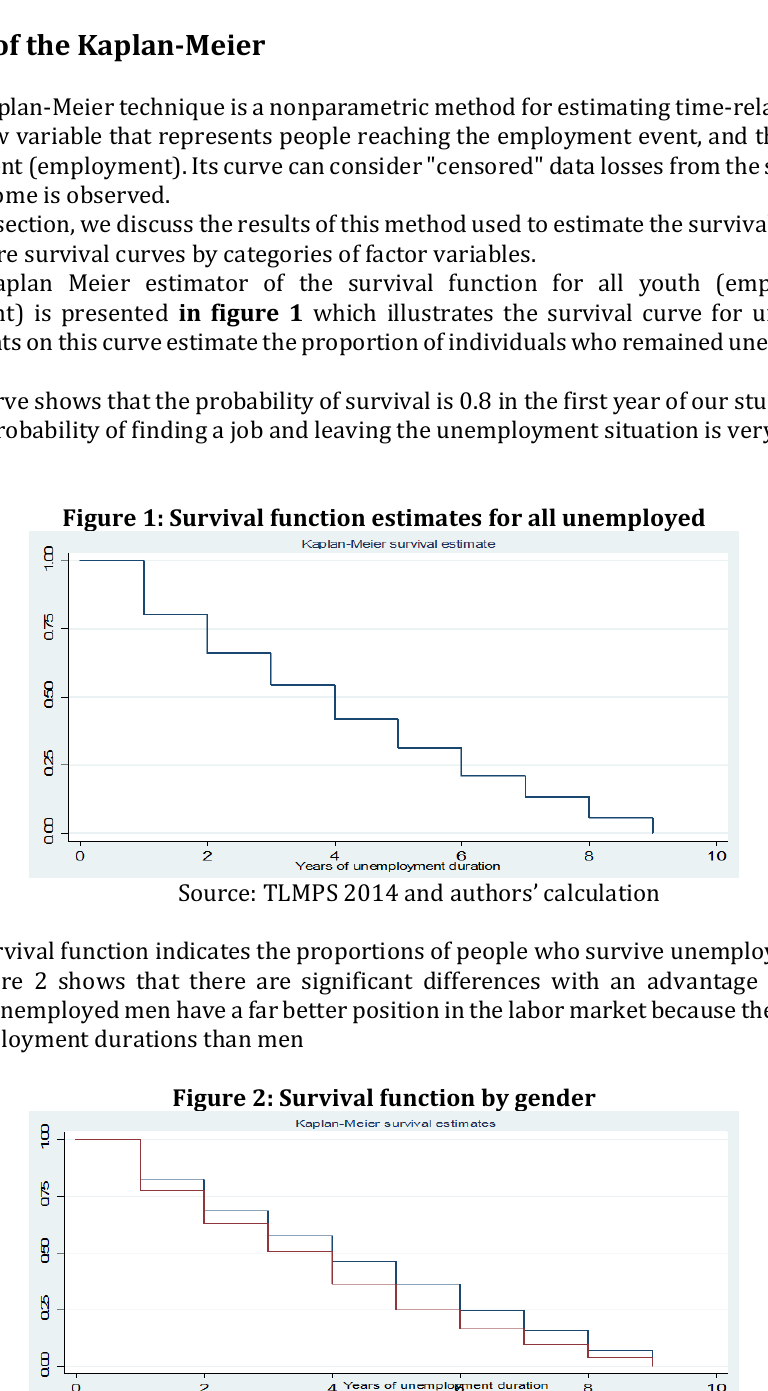
Source: TLMPS 2014 and authors’